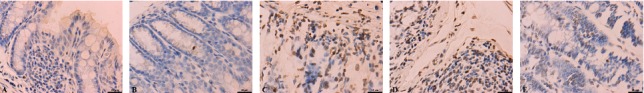
Apoptosis in mouse colon tissue (TUNEL staining, 200×). A, blank control group; B, model group; C, low-dose BBR group; D, medium-dose BBR group; E, high-dose BBR group.